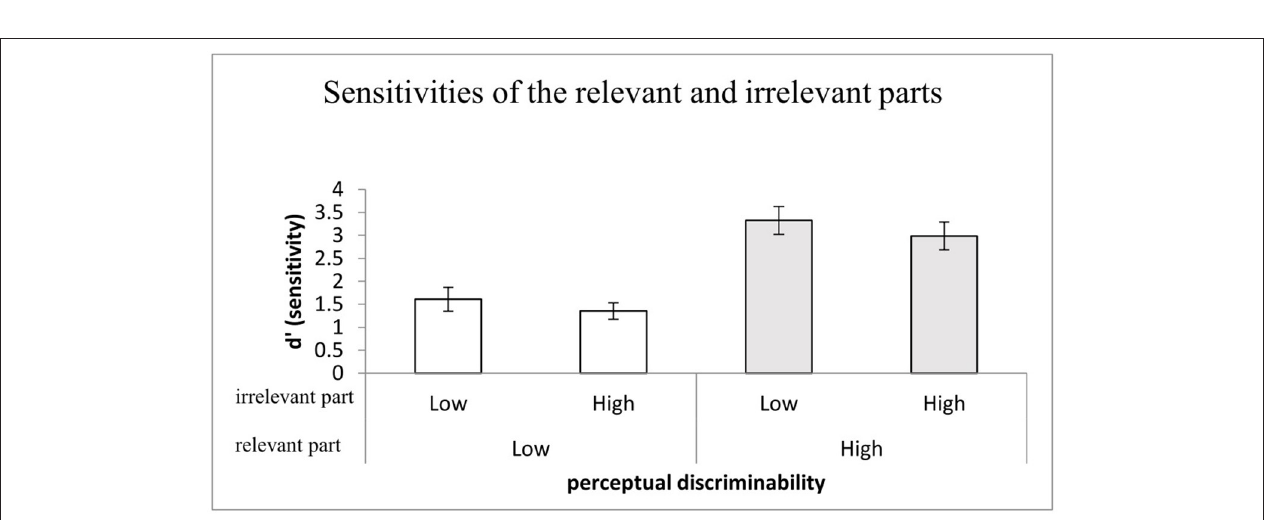
FIGURE 5 | The mean d’ for perceptual discriminability as a function of the relevant (target) part and irrelevant (non-target) part discriminability; error bars indicate 95% confidence interval calculated within